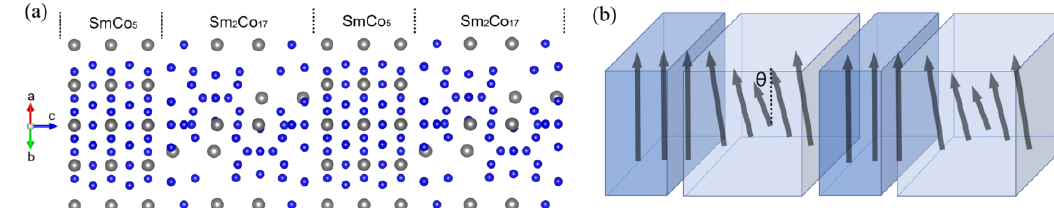
Figure 1. ( a ) Atomic configurations of the two phase multilayered system. The 5-monolayer (ML) of hard (SmCo 5 ) and 7-ML of soft (Sm 2 Co 17 ) phases are aligned along (0001) direction. The gray large, blue small balls represent Sm and Co atoms, respectively. The dotted lines on top of panel indicate the interface between two phases. The periodic boundary condition has been used; ( b ) A schematic diagram of non-collinear magnetic orderings in the systems. The arrows represent the directions of magnetic moments of the atoms in each layer. By total energy calculation, it is confirmed that spin prefers to rotate along in-plane (parallel to interface). θ is the angle between the directions of magnetic moments of the atoms in the hard phase and those in the middle layer of the soft phase, which are